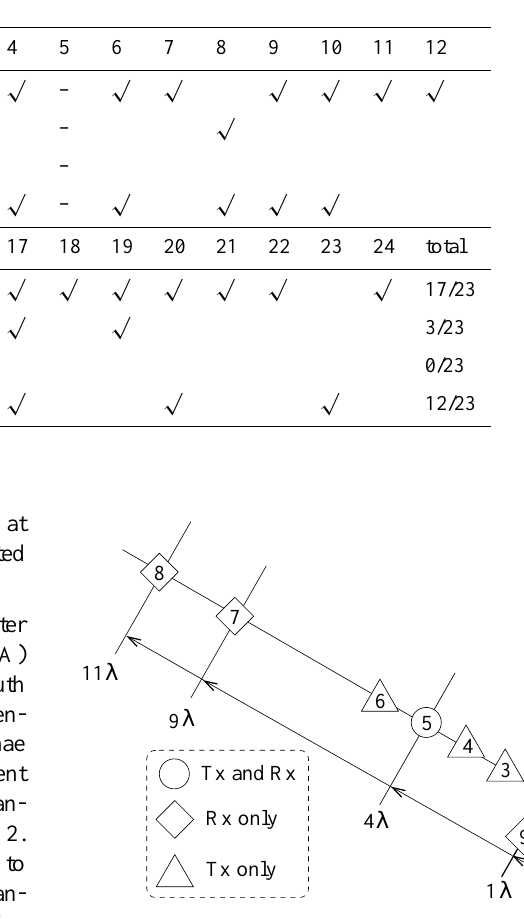
Fig. 2. Antenna layout for the LTPR. T x array consists of antennae 1–6, while Rx array consists of antennae 1, 2, 5, 7, 8, and 9.